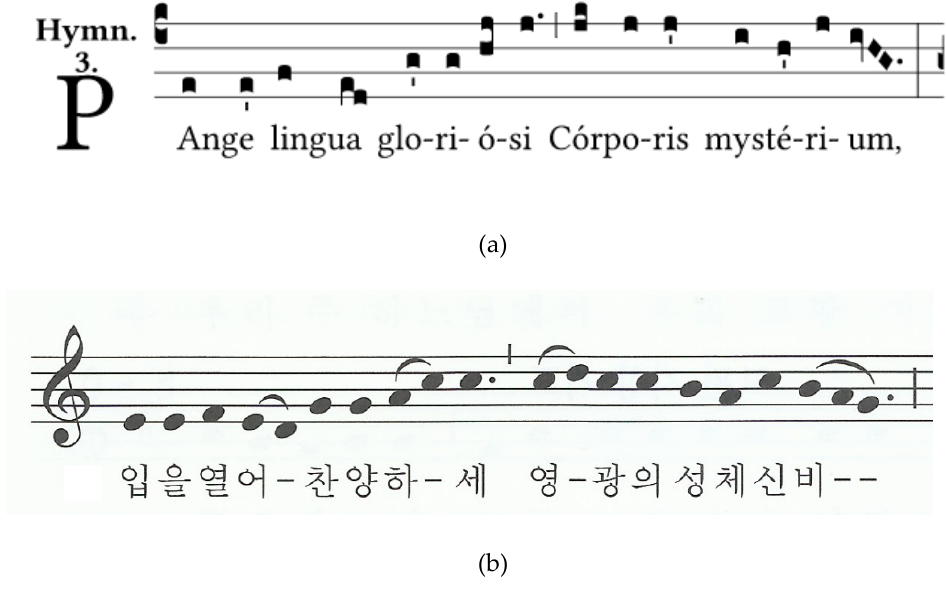
Figure 3. Comparison between the original Latin ( a ) and Korean ( b ) scores of “Pange Lingua” (A Database of Gregorian Scores 2021; Catholic Conference of Korea 2021).